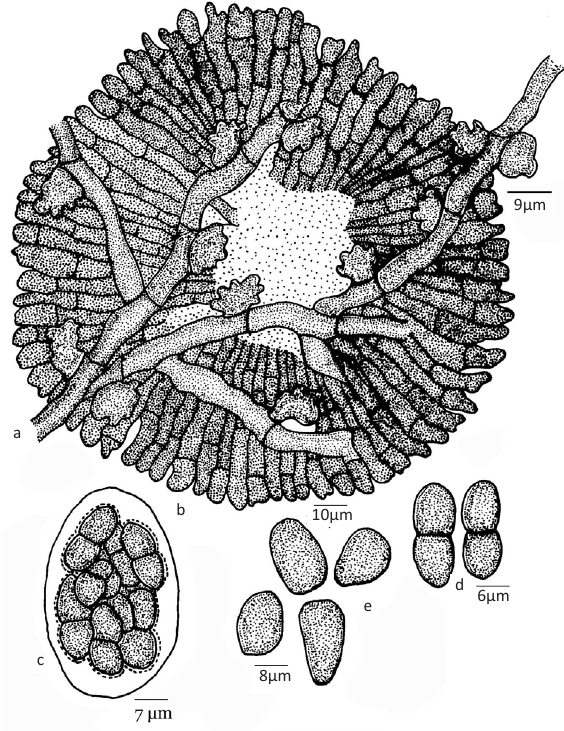
Figure 1. Asterina mananthavadiensis sp. nov. a - Appressoriate mycelium; b - Thyriothecium; c - Ascus; d - Ascospores; e - Pycnothyriospores